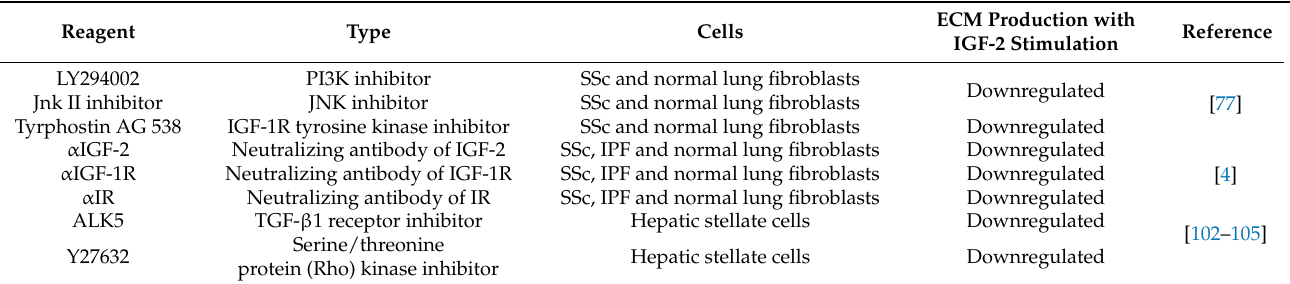
Table 1. Inhibitors of IGF-2-stimulated ECM production.